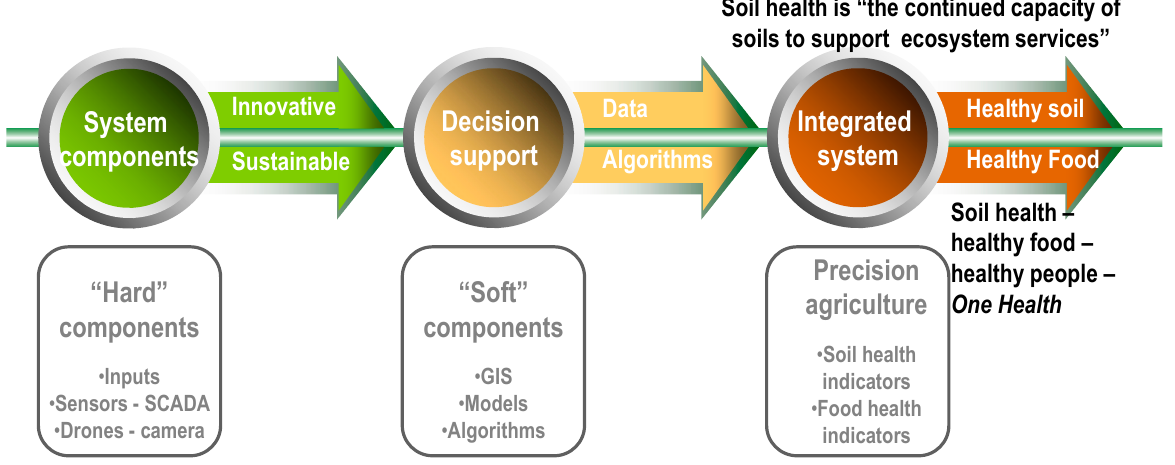
Figure 7. The digital dimension integrated into the precision agricultural systems supports the application of the recovered nutrients for enhanced soil health.